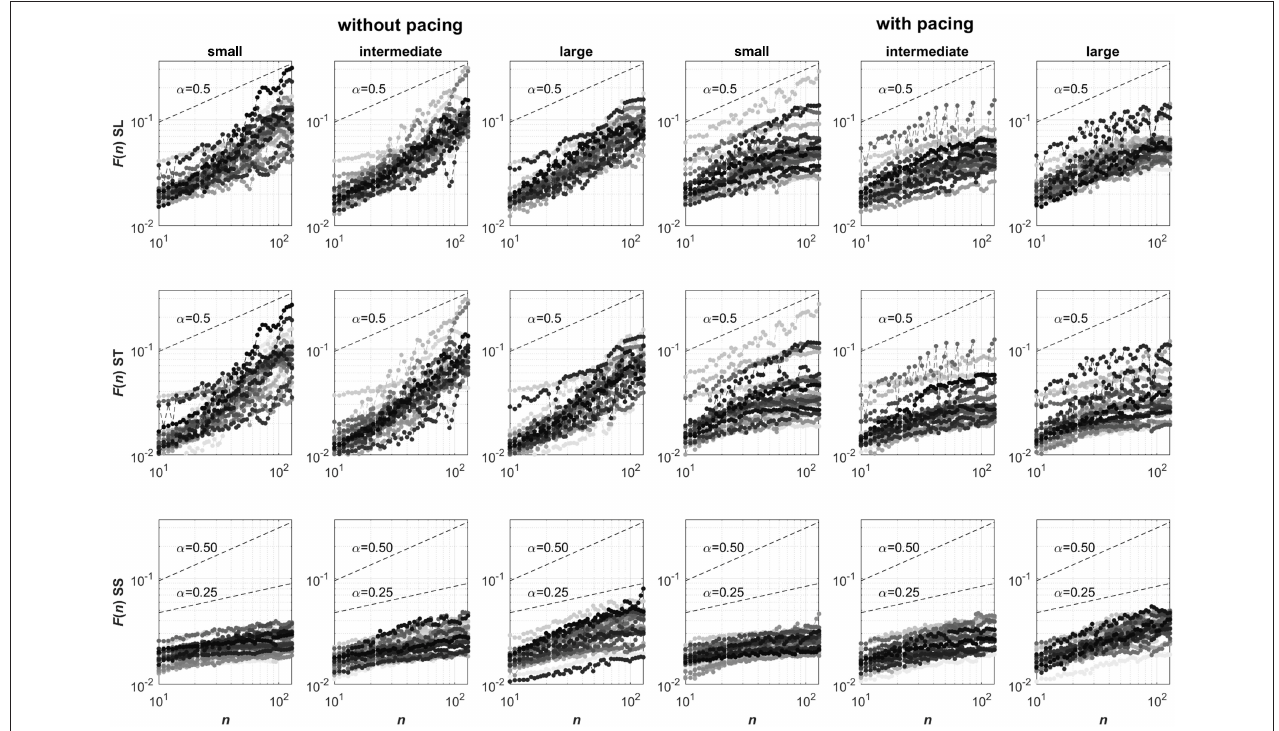
FIGURE 1 | Log-log representations of F against n (ranging from n = 10 to n = 128) for stride-length (SL, top row), stride-time (ST, center row) and stride-speed (SS, bottom row) series. Columns represent the six Pacing by Walking Area conditions. In each panel, 24 curves are depicted with a unique grayscale for each participant. Note that the curves for stride speeds consistently have slopes smaller than 0.5, suggesting anti-persistence in the series, whose degree seemingly varied over the three walking area conditions. The curves for stride-length and stride-time series are less consistent but overall seemed to have slopes greater than 0.5 without pacing (suggesting persistence) and smaller than 0.5 with pacing (suggesting anti-persistence), without clear effects of the walking-area manipulation. The strong resemblance in the stride-length and stride-time representations of individual participants may point to a strong coupling between these two gait